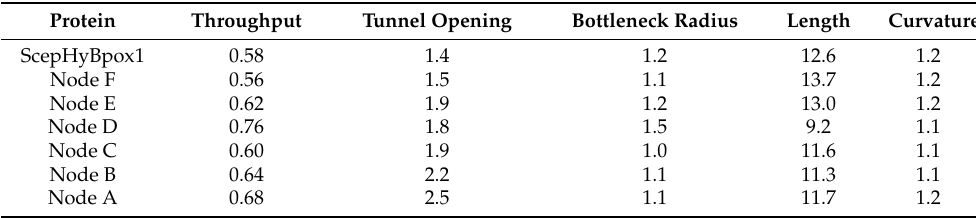
Figure 6. Presentation of 3D models for S. cepivorum Hybrid B heme peroxidase and its six ancestors (nodes A–F, shown in Figure 3) reconstructed with AlphaFold 2 [25]. The tunnel is seen most clearly in Node A and in all other structures it is narrowing. The prosthetic heme group at the end of the tunnel is coloured cyan. Table 1. Comparison of the tunnels with the heme cavity in analysed peroxidases calculated by Caver software